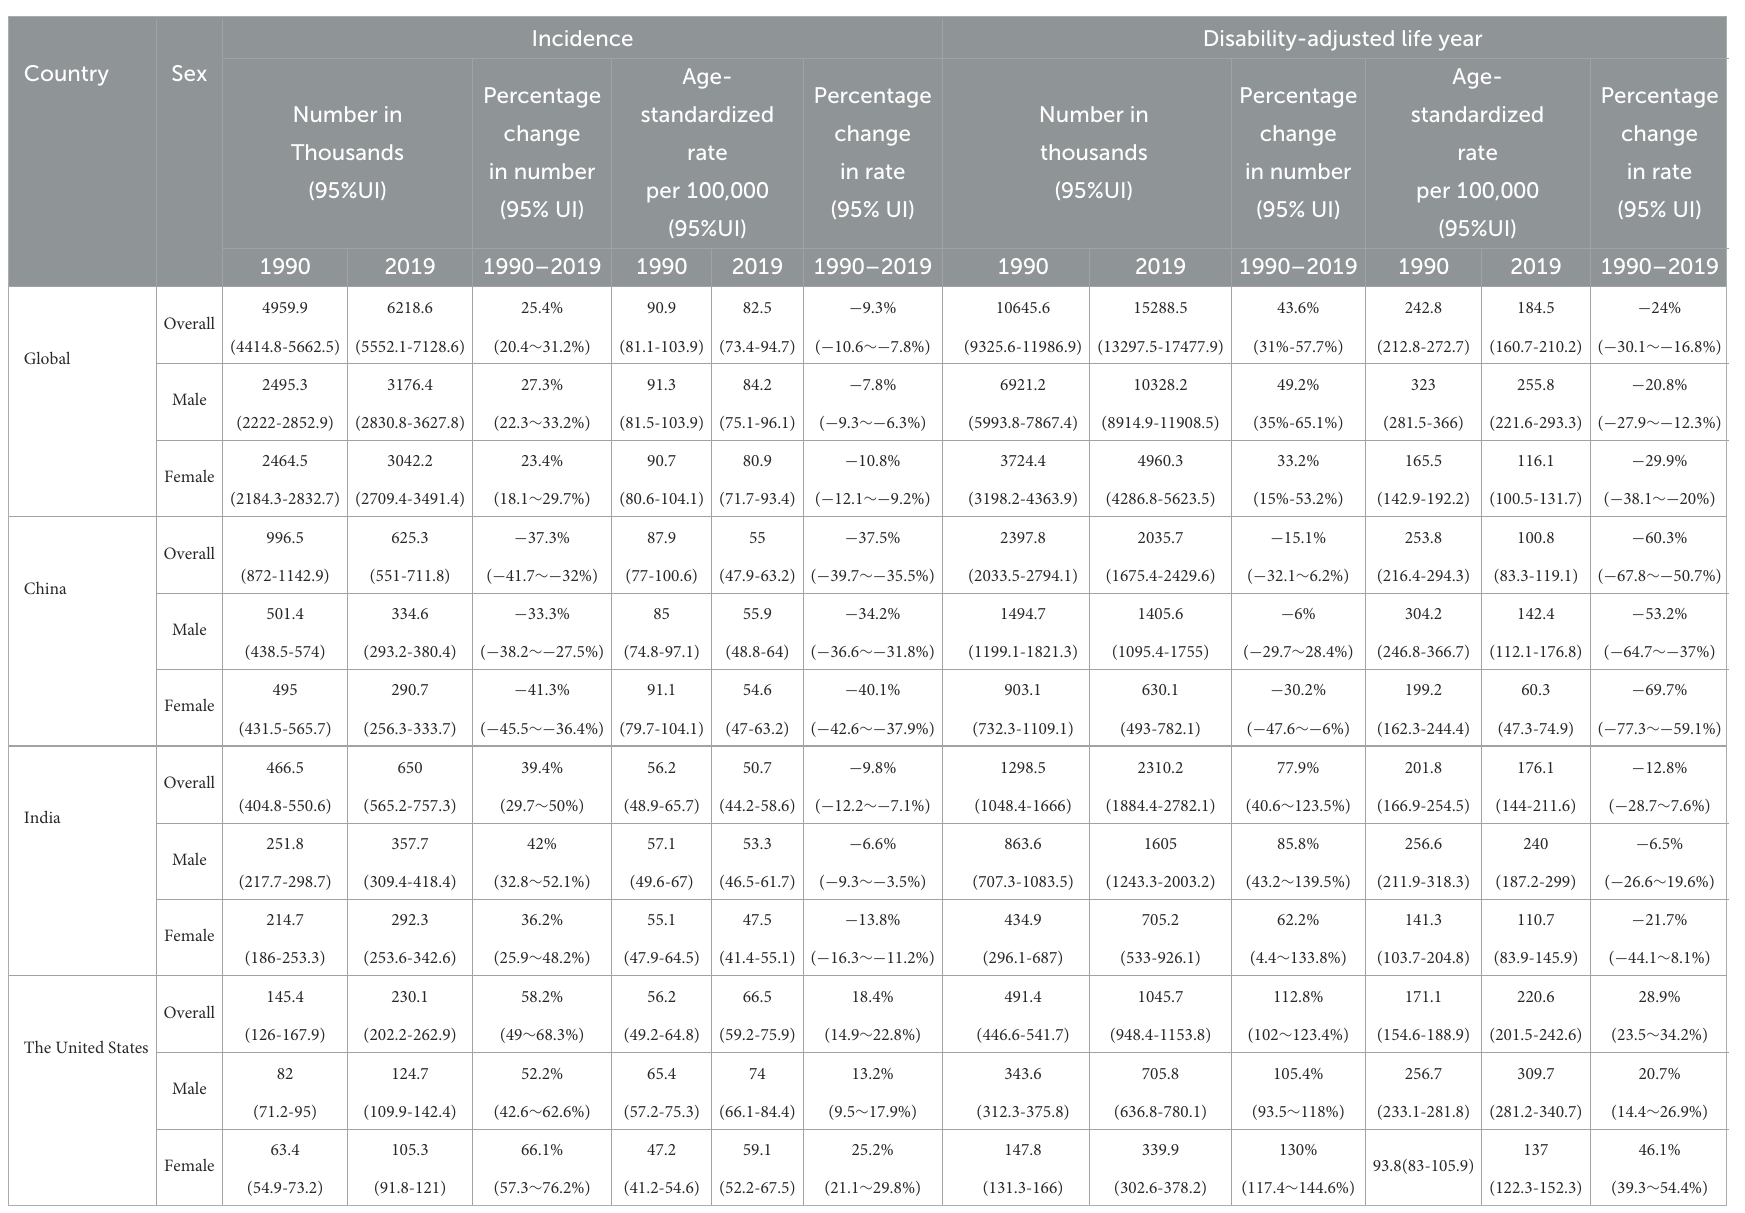
TABLE 1 Incidence and disability-adjusted life year, age-standardized rates, and their temporal trends of HCV infection in different regions, 1990 vs. 2019.